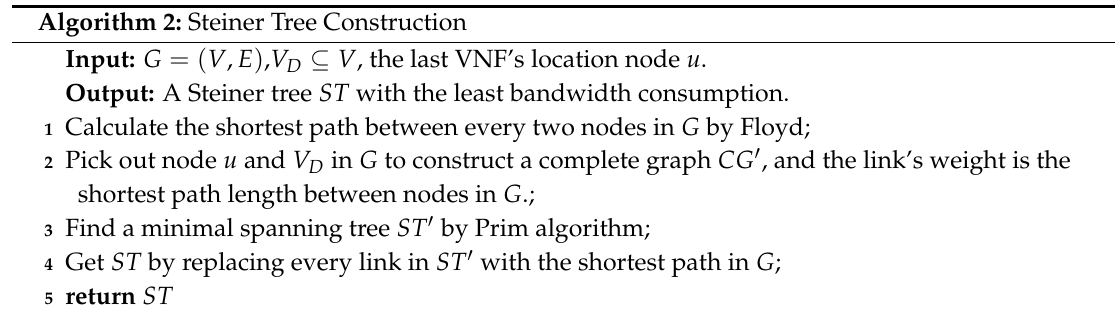
Algorithm 2: Steiner Tree